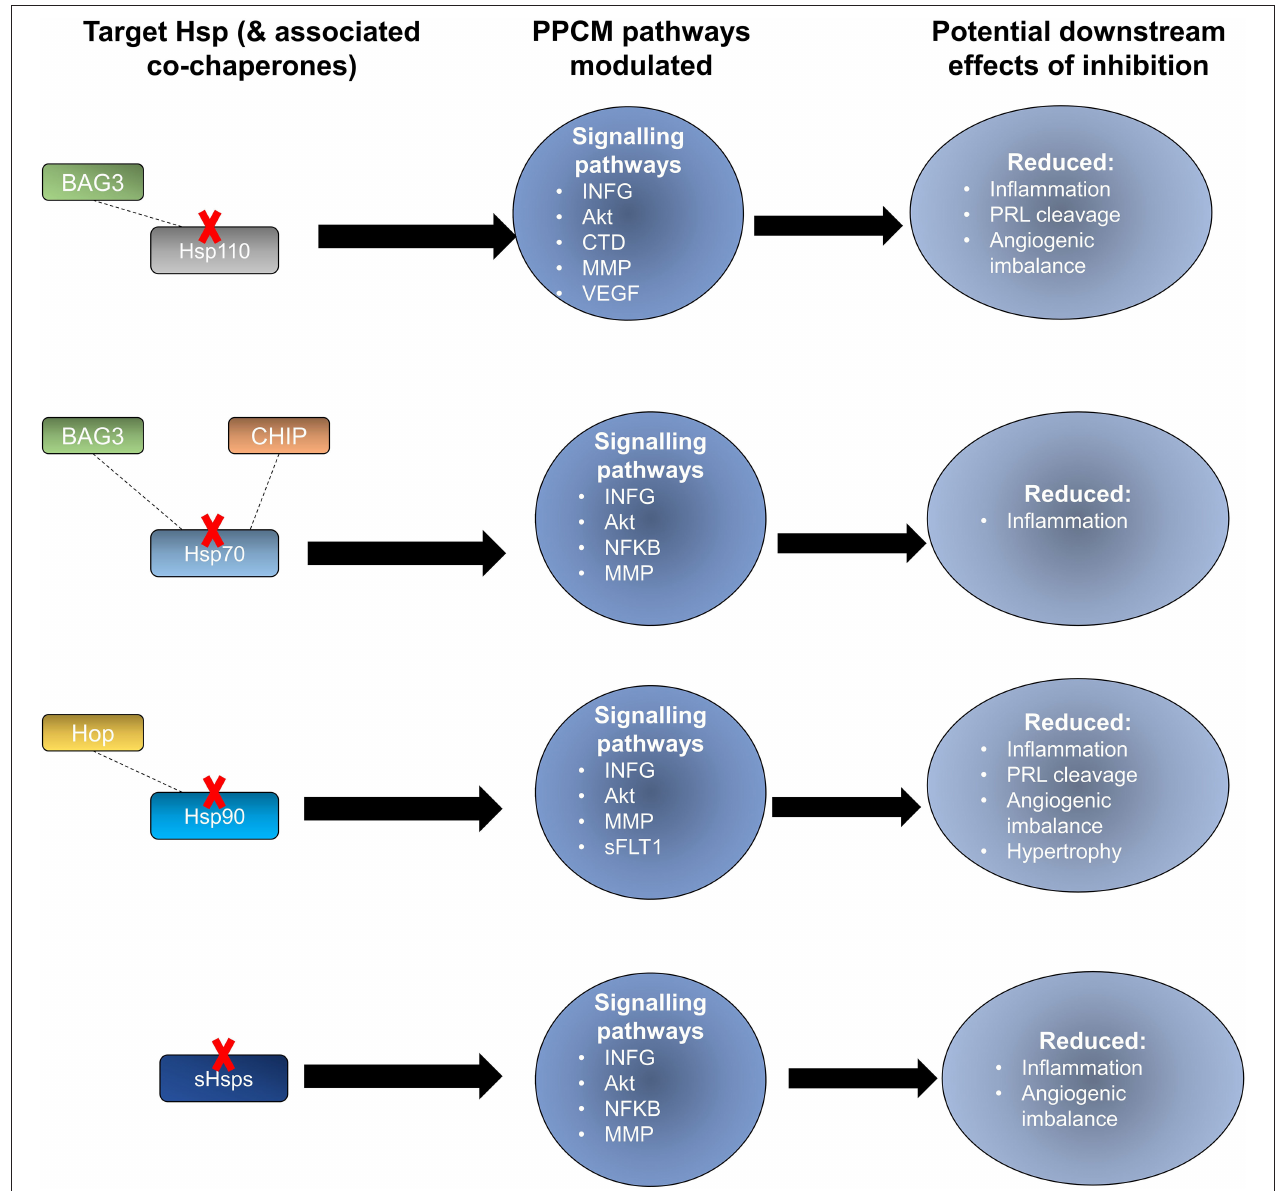
FIGURE 6 | Potential effects of Hsp-directed inhibition in PPCM therapy. Targeting the Hsp types sHsp, Hsp110, Hsp90, and Hsp70 has the potential to disrupt key signalling pathways that are important in PPCM pathophysiology.